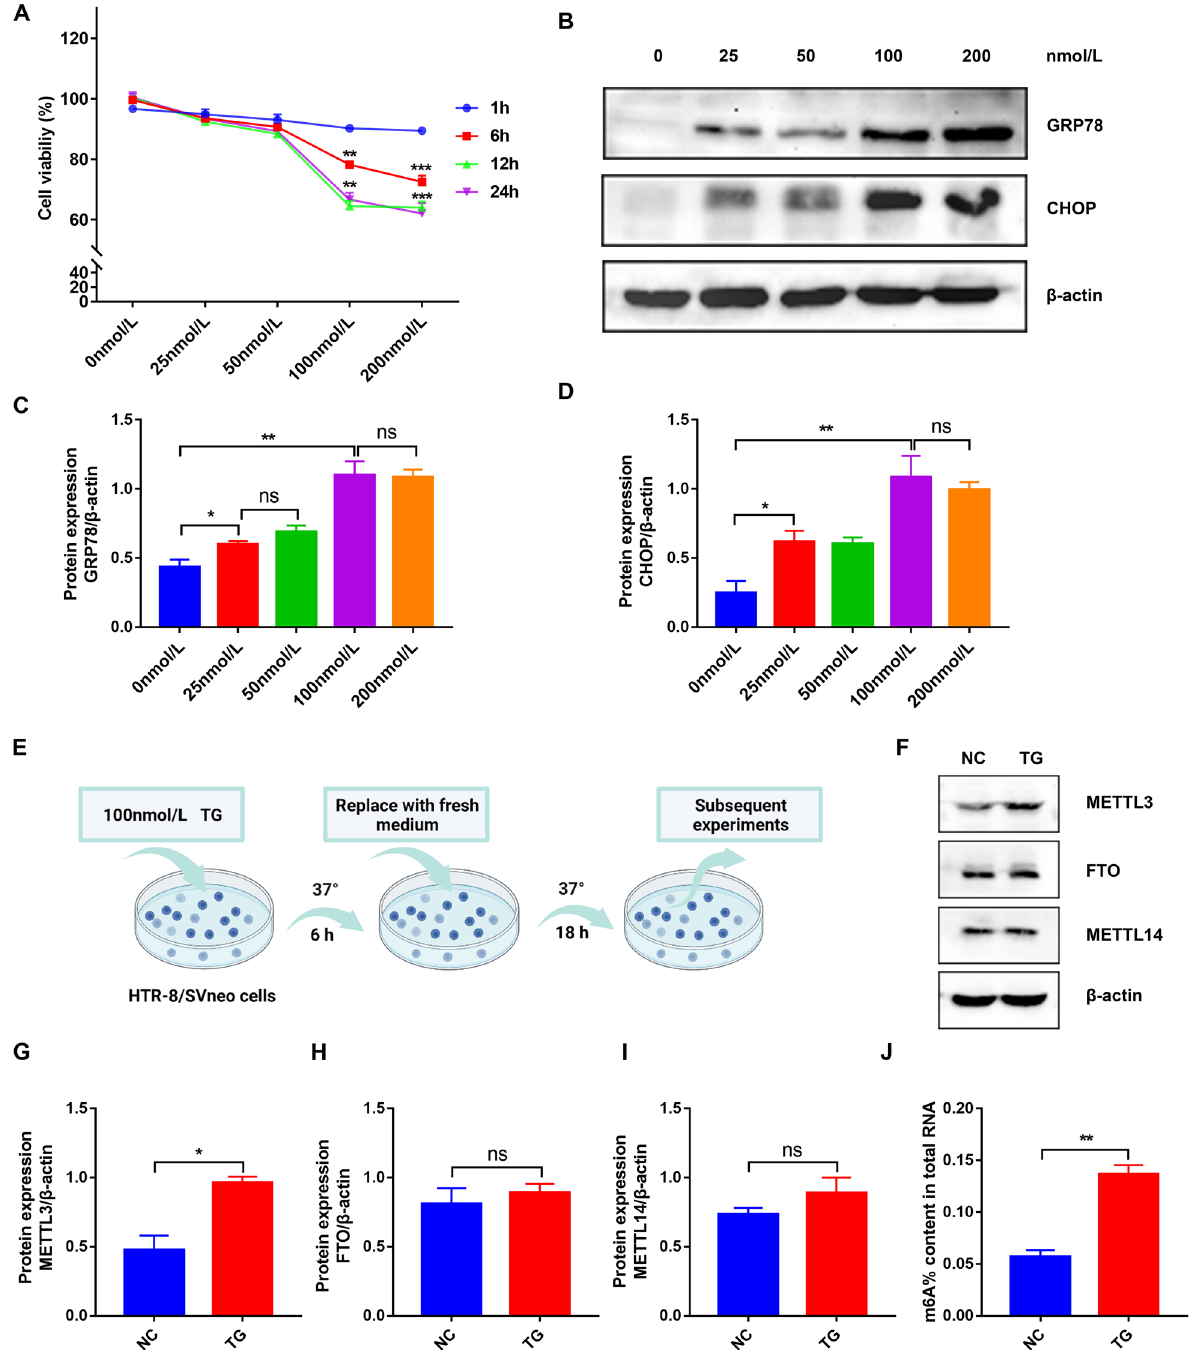
Fig. 2 Construction of ER stress model in HTR-8/SVneo cells where METTL3 expression and m 6 A level were upregulated. A Cell viability determined by the CCK8 analysis. B – D Representative WB images and densitometry quantification of GRP78 and CHOP. The data were normalized to β-actin. E Flow diagram of constructing ER stress model. HTR-8/SVneo cells were treated for 6 h with 100 nmol/L TG and another 18 h with fresh medium and used for the following experiments. F – I Representative WB images and densitometry quantification of METTL3, FTO and METTL14. The data were normalized to β-actin. J The m 6 A levels determined by m 6 A colorimetric assay. n 3. ns: no significance, *p < 0.05, **p < 0.01, ***p < =